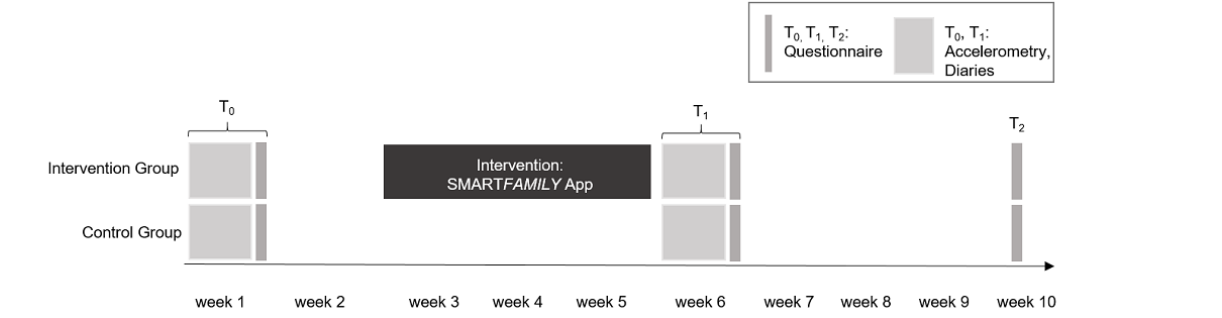
Figure 1. Detailed study design. T0: baseline; T1: after 3 weeks of intervention; T2: Four weeks after T1.